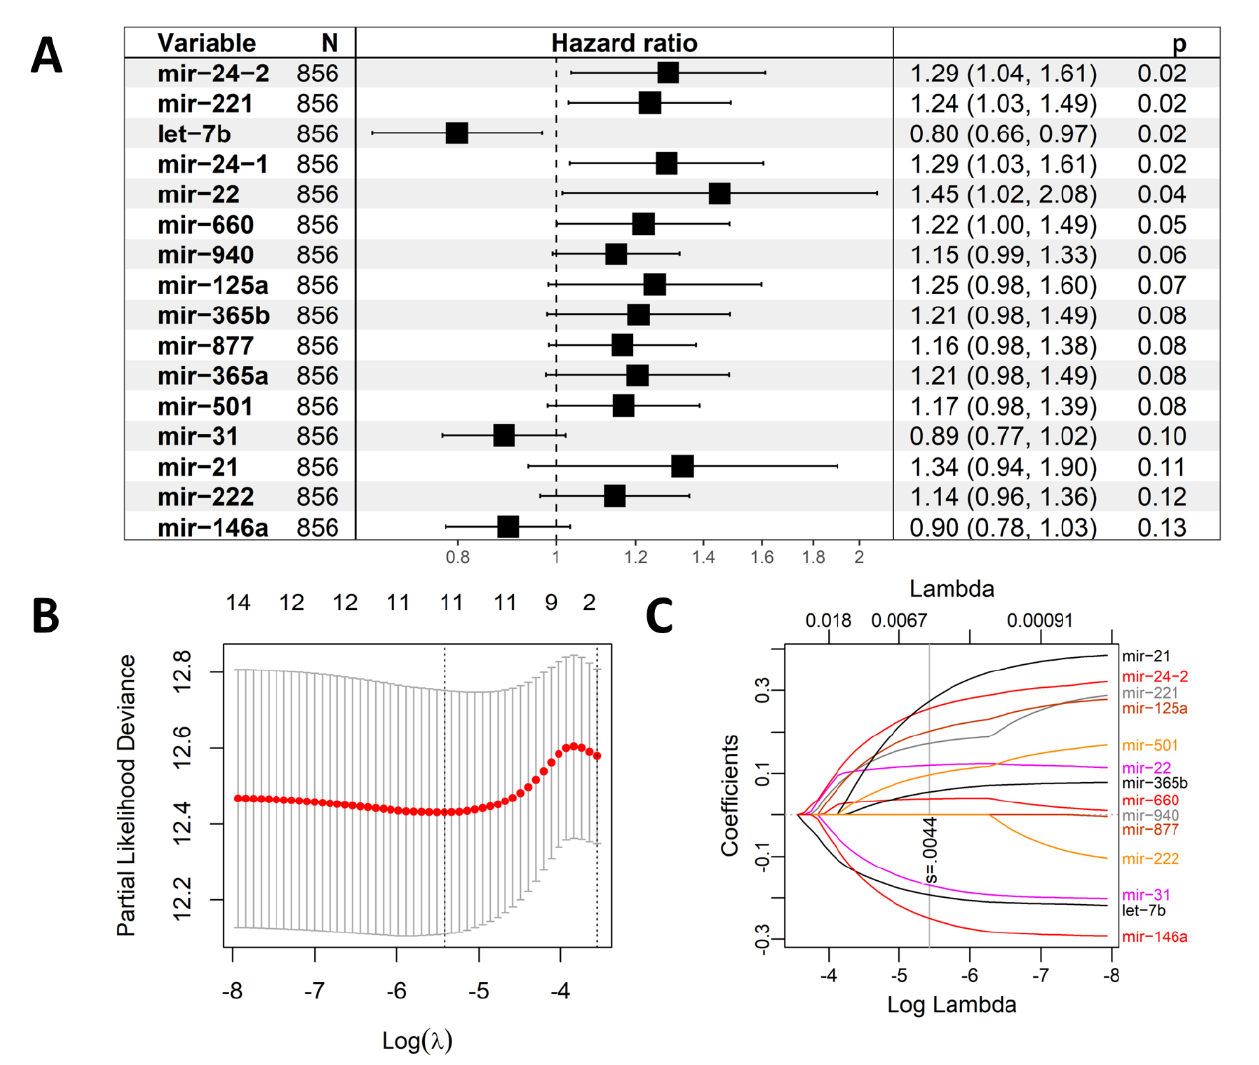
Figure 2. Cox regression analysis. ( A ) The 16 TAM-related miRNAs with p value < 0.15 and their hazard ratios from univariate Cox proportional hazards regression analysis. ( B ) Tuning parameter ( λ ) selection in the LASSO model for OS-relevant miRNAs. ( C ) The LASSO coefficient profile of the 16 miRNAs. The vertical line indicates the coefficient selected by LASSO.